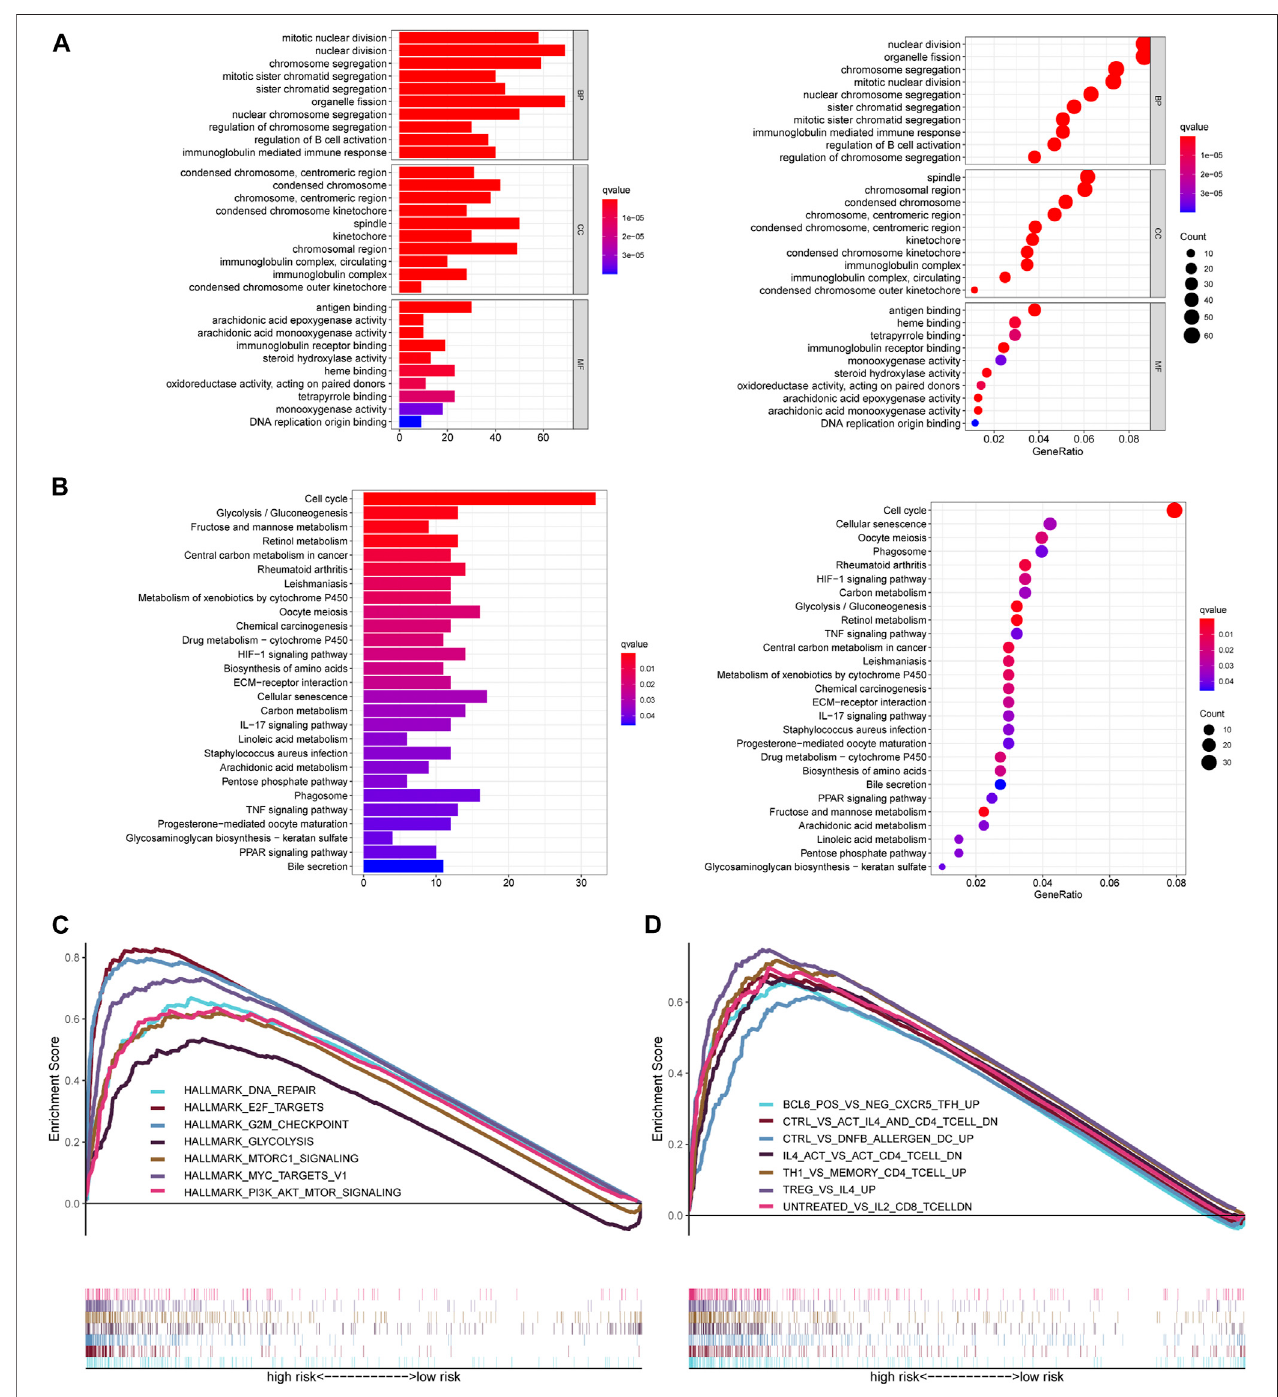
FIGURE 5 | Functional analysis of the ferroptosis-related lncRNA signature. (A) GO enrichment analysis of ferroptosis-related lncRNAs. (B) KEGG pathway enrichment analysis of ferroptosis-related lncRNAs. (C, D) Several cancer hallmarks (C) and immunologic characteristics (D) are regulated via the immune-related lncRNA signature. lncRNA: long noncoding RNA; GO: Gene Ontology; KEGG: Kyoto Encyclopedia of Genes and